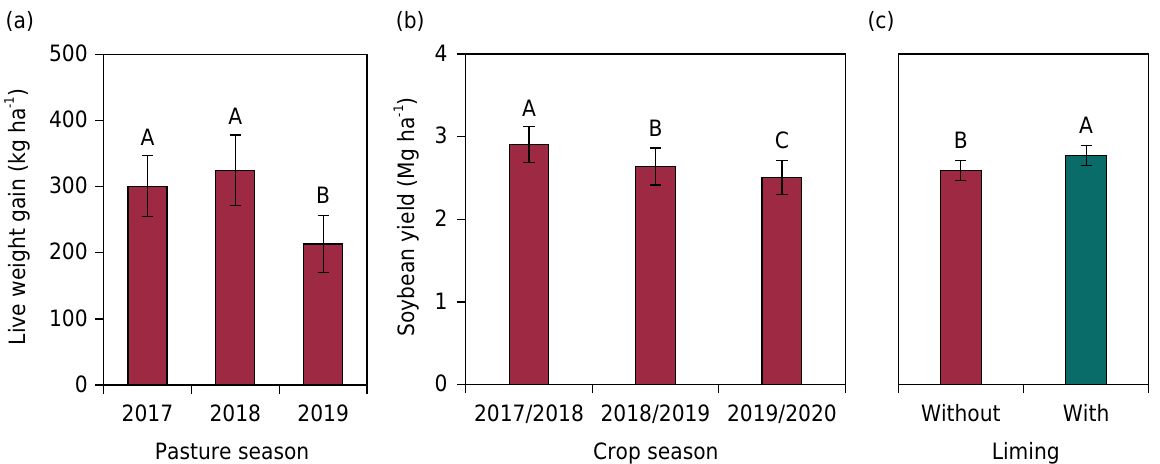
Figure 5. Live weight gain of sheep per unit area in each pasture season (a), and soybean yield as affected by crop season (b) and liming (with or without) (c). Different letters denote significant differences as per Tukey’s test